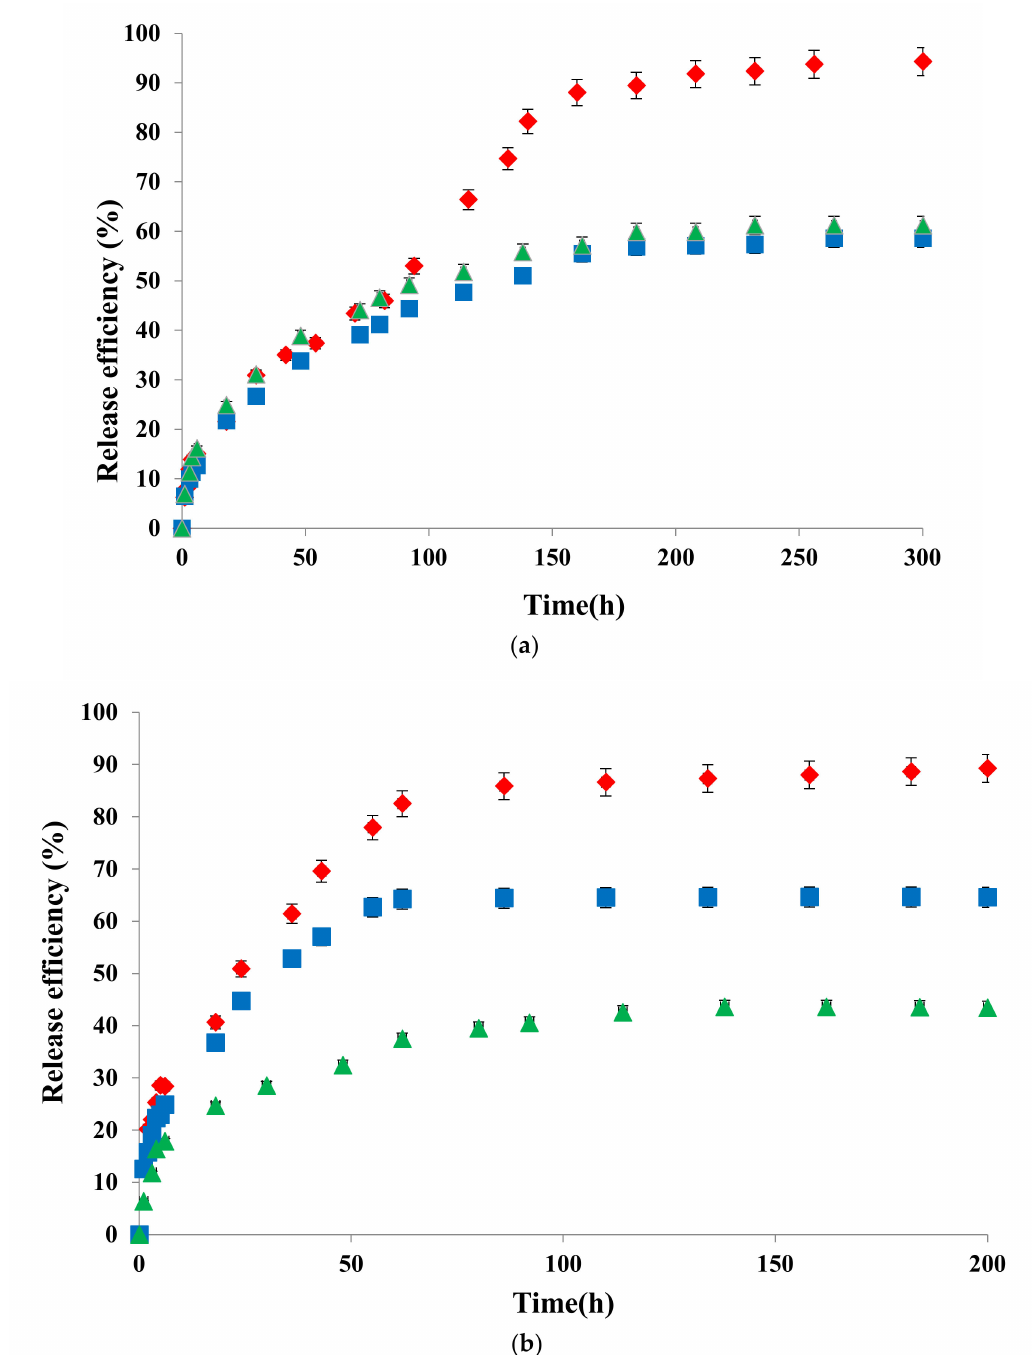
Figure 2. Curcumin ( a ) and 5-FU ( b ) release e ffi ciency as a function of time at pH 2 (diamonds), pH 6.8 (squares), and pH 7.4 (triangles) and 37 ◦